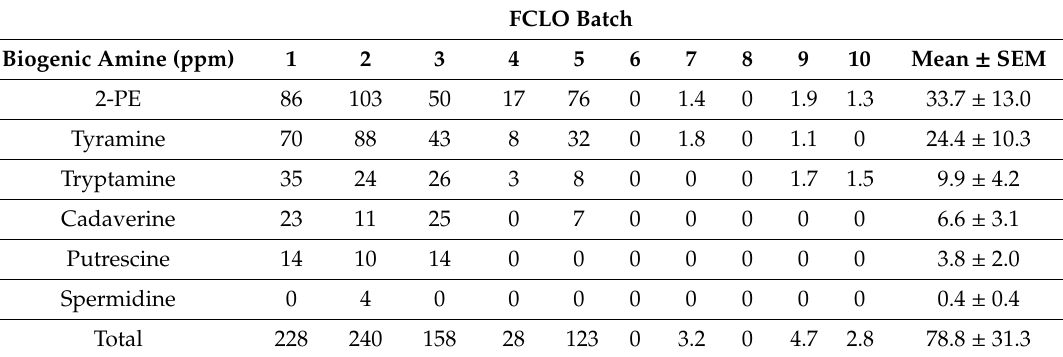
Table 5. (BA concentrations (ppm) of n = 10 separate batches of a FCLO product. Total BA and corresponding mean ± SEM values are also provided. Histamine and spermine were undetectable in all samples analyzed. FCLO